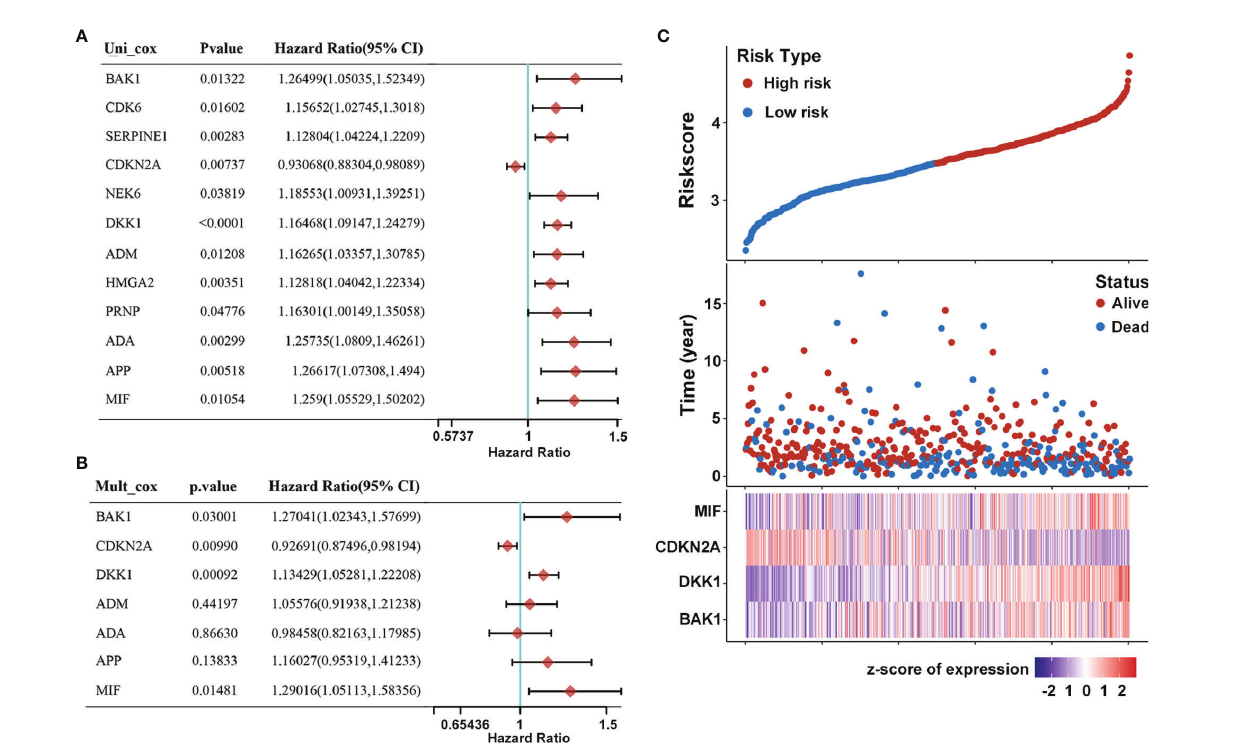
FIGURE 2 | Construction of prognostic risk model of AGs for HNSCC patients. (A) Forest plot of 12 AGs that related to overall survival via univariate Cox regression analyses. (B) Multivariate Cox regression analyses of 7 prognosis-associated AGs. (C) Risk plot distribution, survival status of patients, and heat map of expression of included genes in the whole TCGA-HNSC